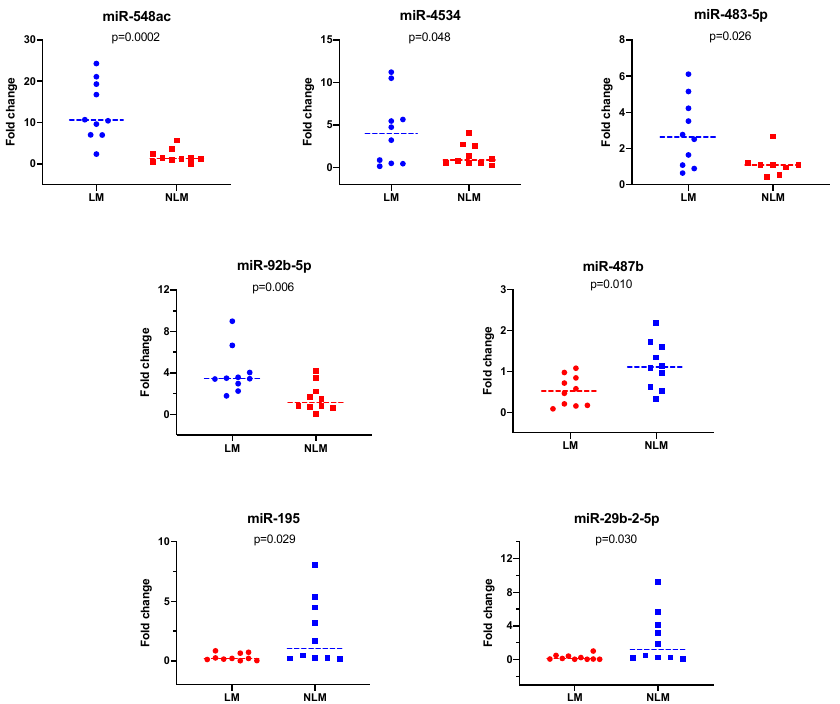
Figure 2. The seven miRNAs validated by RT-qPCR experiments. We were able to validate the expression of 7 of the 10 selected miRNAs by RT-qPCR experiments. miR-548ac, miR-4534, miR-483-5p, and miR-92b-5p were overexpressed, whereas miR-487b, miR-195, and miR-29b-2-5p were underexpressed. LNM+: patients with lymph node metastasis, LNM − : patients without lymph node metastasis. miRNAs underexpressed in the microarray that were subjected to validation. The miRNAs miR-487b, miR-29b, and miR-195 were validated by RT-qPCR. LM: patients with lymph node metastasis, NLM: patients without lymph node metastasis.